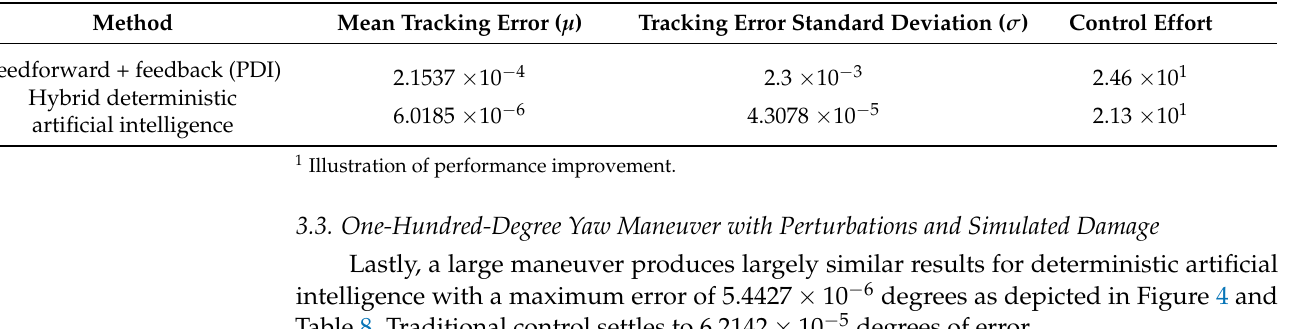
Table 8. Traditional control settles to 6.2142 × 10 − 5 degrees of error.